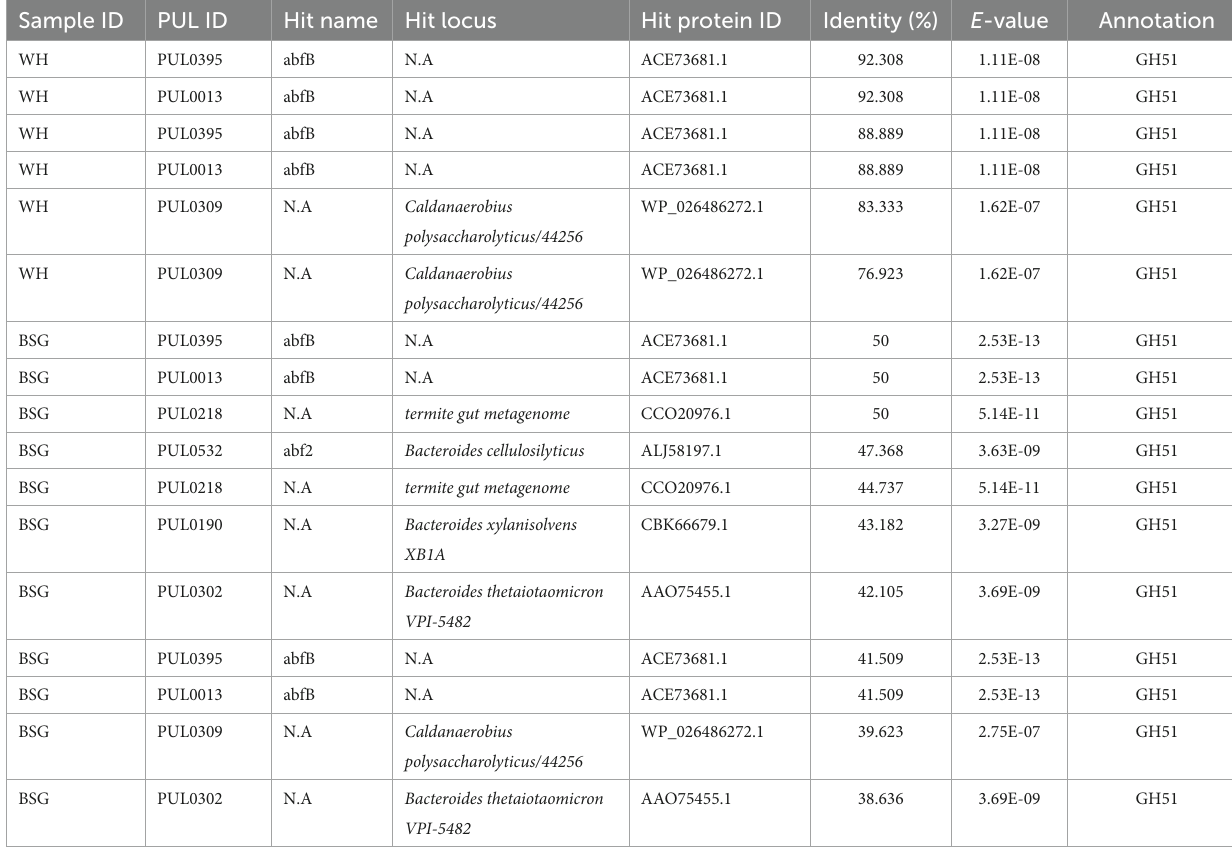
TABLE 4 Polysaccharide utilization loci (PUL) hits identified in black soldier fly larvae reared on high-fiber diets. Sample